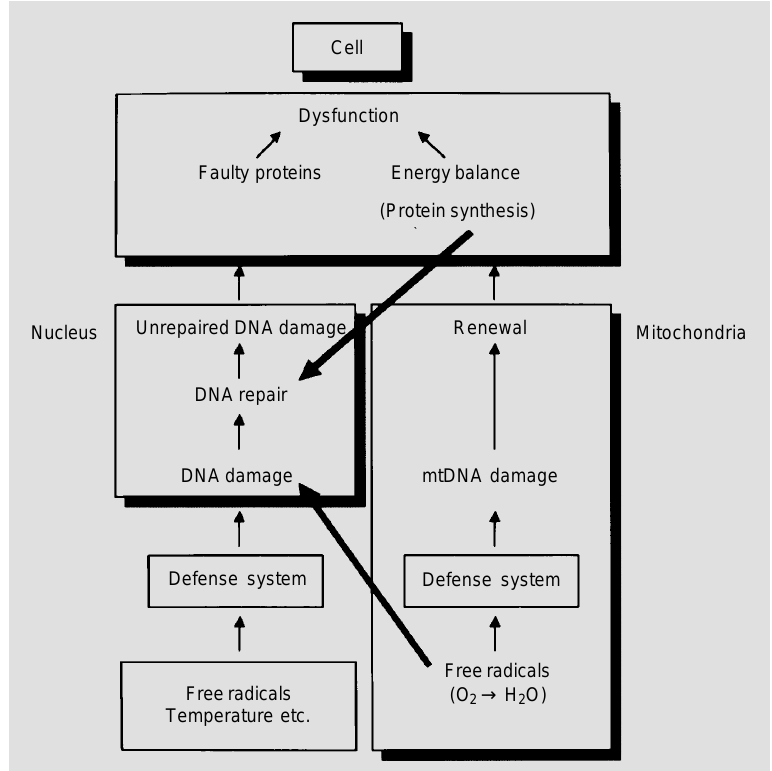
Figure 7 - Scheme of events within the nucleus and mitochondria according to leading hypotheses for explaining the phenomenon of aging. For details, see